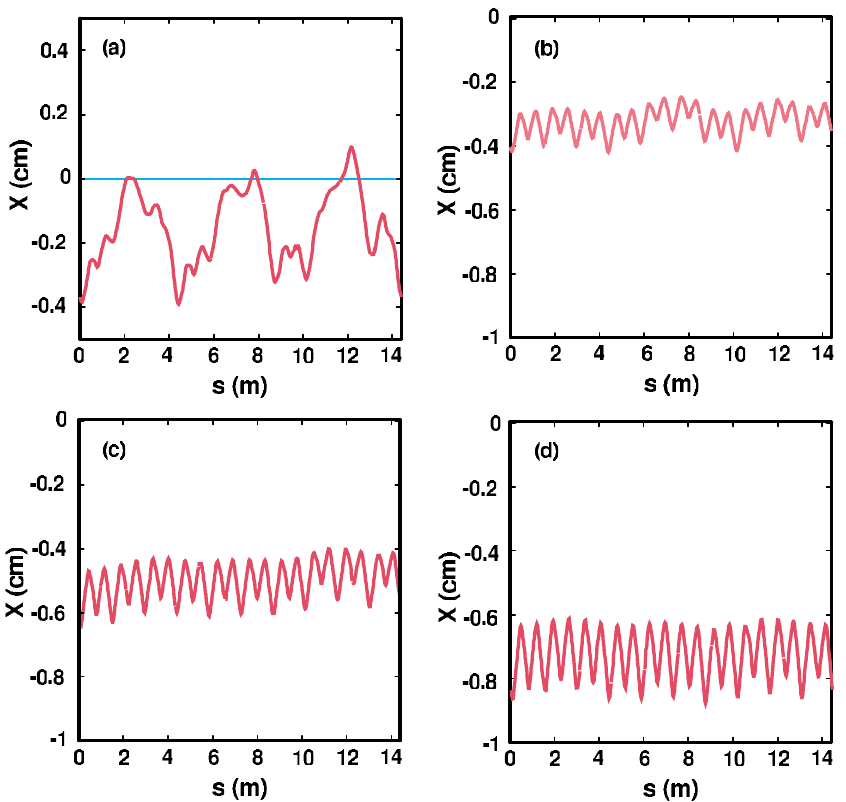
FIG. 5. (Color) Final-lap centroid histories showing the effects of applying a velocity tilt more gradually in a lattice with ten equally spaced cells. Trapezoidal pulses have been applied in the first (a) 10, (b) 50, (c) 100, and (d) 150 cells, with the head-to-tail voltage increase adjusted to give the same overall compression. Note that a different vertical scale is used in (a) to accommodate the larger centroid